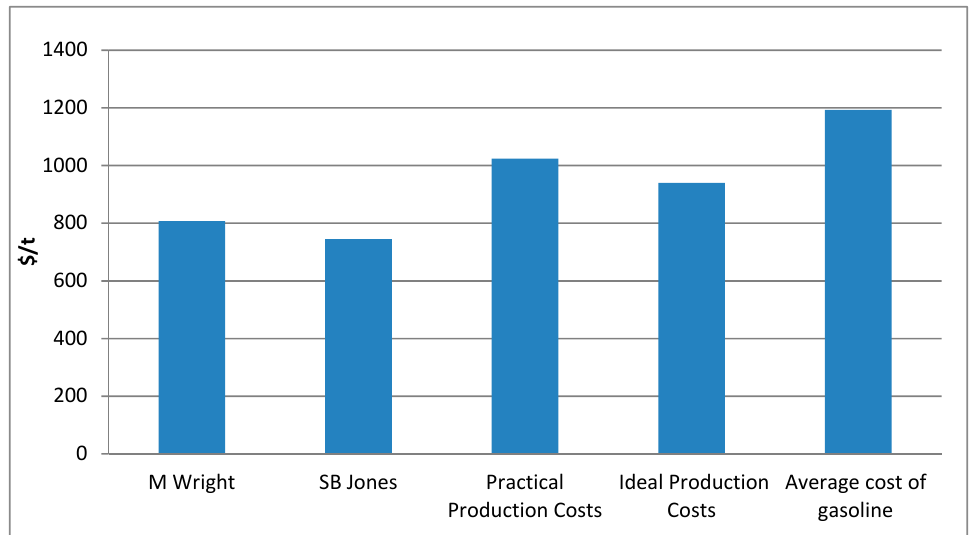
Figure 7. Comparison of simulated production cost and the average cost of Chinese gasoline in 2018 [7,13].